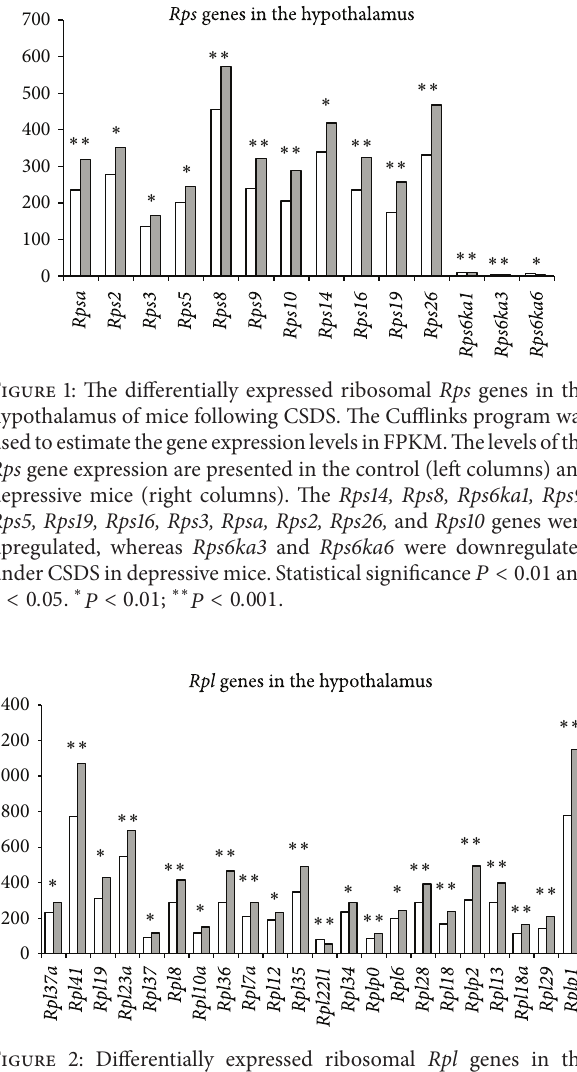
Figure 2: Differentially expressed ribosomal Rpl genes in the hypothalamus of mice following CSDS. The Cufflinks program was usedtoestimatethegeneexpressionlevelsinFPKM.Thelevelsofthe Rpl genes expression are presented in the control (left columns) and depressive mice (right columns). The Rpl37a, Rpl41, Rpl19, Rpl23a, Rpl37, Rpl8, Rpl10a, Rpl36, Rpl7a, Rpl12, Rpl35, Rpl34, Rplp0, Rpl6, Rpl28, Rpl18, Rplp2, Rpl13, Rpl18a, Rpl29, and Rplp1 genes were upregulated,whereasthe Rpl22l1 genewasdownregulated.Statistical significance 𝑃 < 0.01 and 𝑞 < 0.05 . ∗ 𝑃 < 0.01 ; ∗∗ 𝑃 < 0.001